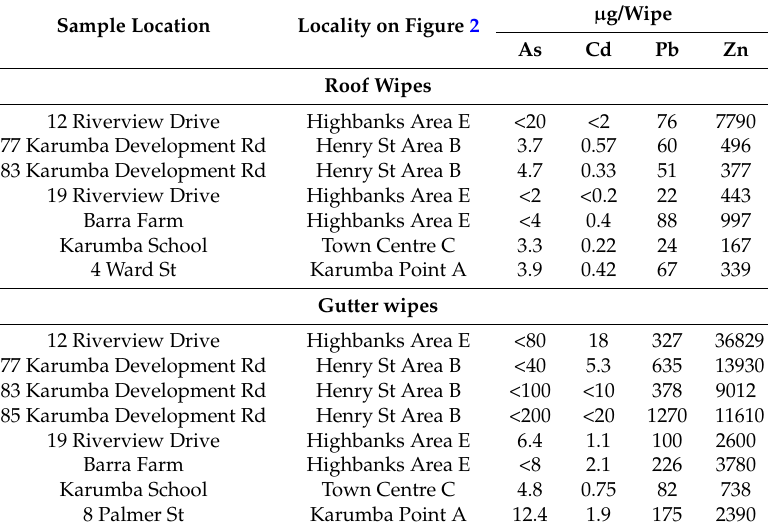
Table 3. Acid digests from roof and gutter surface wipe samples.